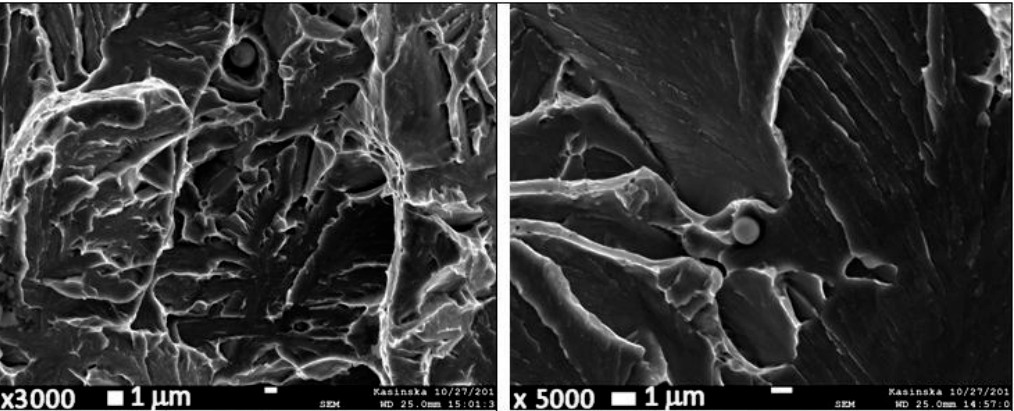
Figure 14. REMs oxysulphides on fracture surfaces of the Charpy-V impact test.